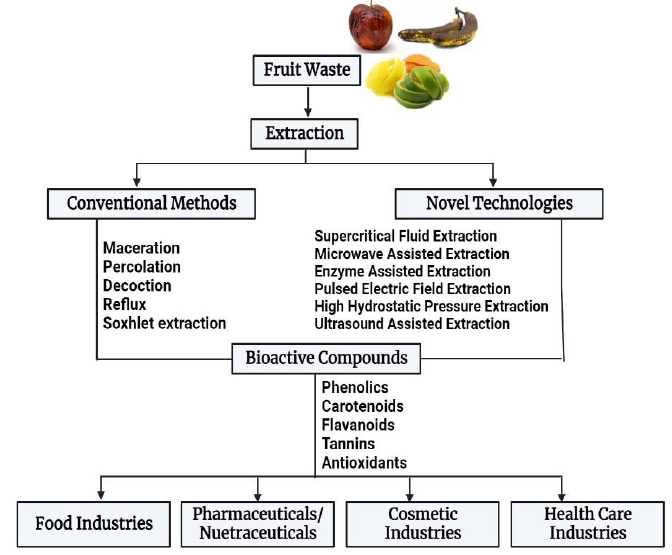
Figure 1. A schematic representation of fruit waste valorization .